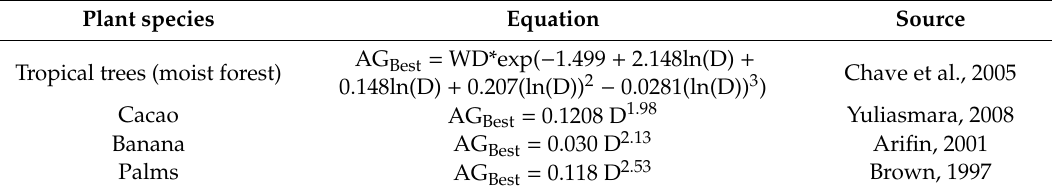
Table 1. Allometric equations for several plant species (AGB est = estimated aboveground biomass (kg); D = diameter at breast height (cm); WD = wood density (g cm − 3